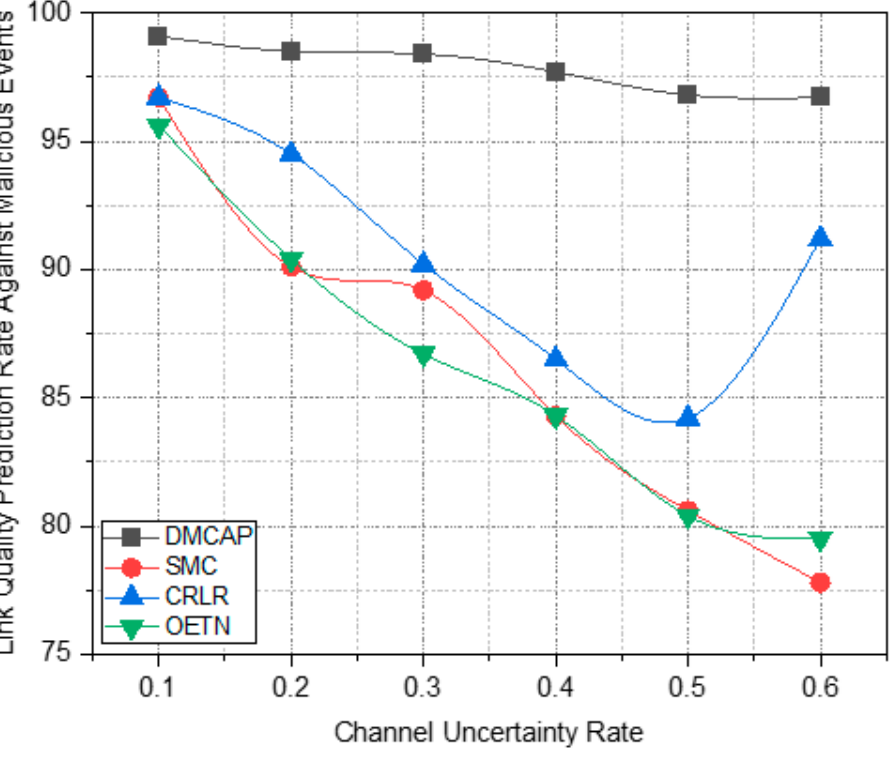
Figure 9. Link quality prediction rate against malicious events.